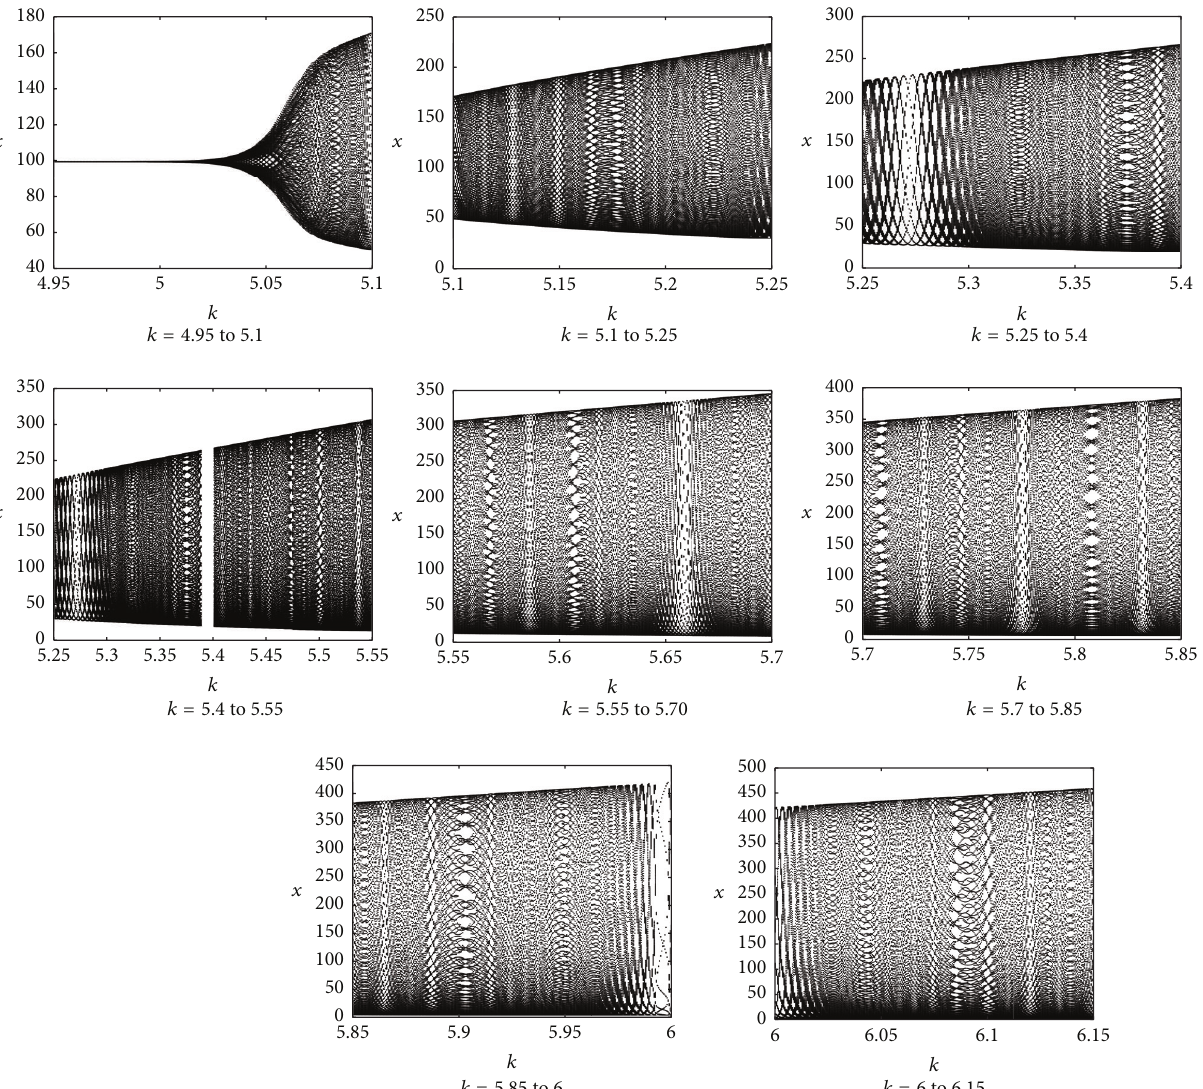
Figure 8: Diagrams of bifurcation of the equilibrium points with respect to 𝑥 for the parameter 𝑘 varying from 4.95 to 6.15, 𝑥 1 = 100.1 , = 1000 for 𝐴 = 1 , 𝑇 = 1000 , 𝛼 = 0.5 , and 𝑠 = 1200 𝑦 1